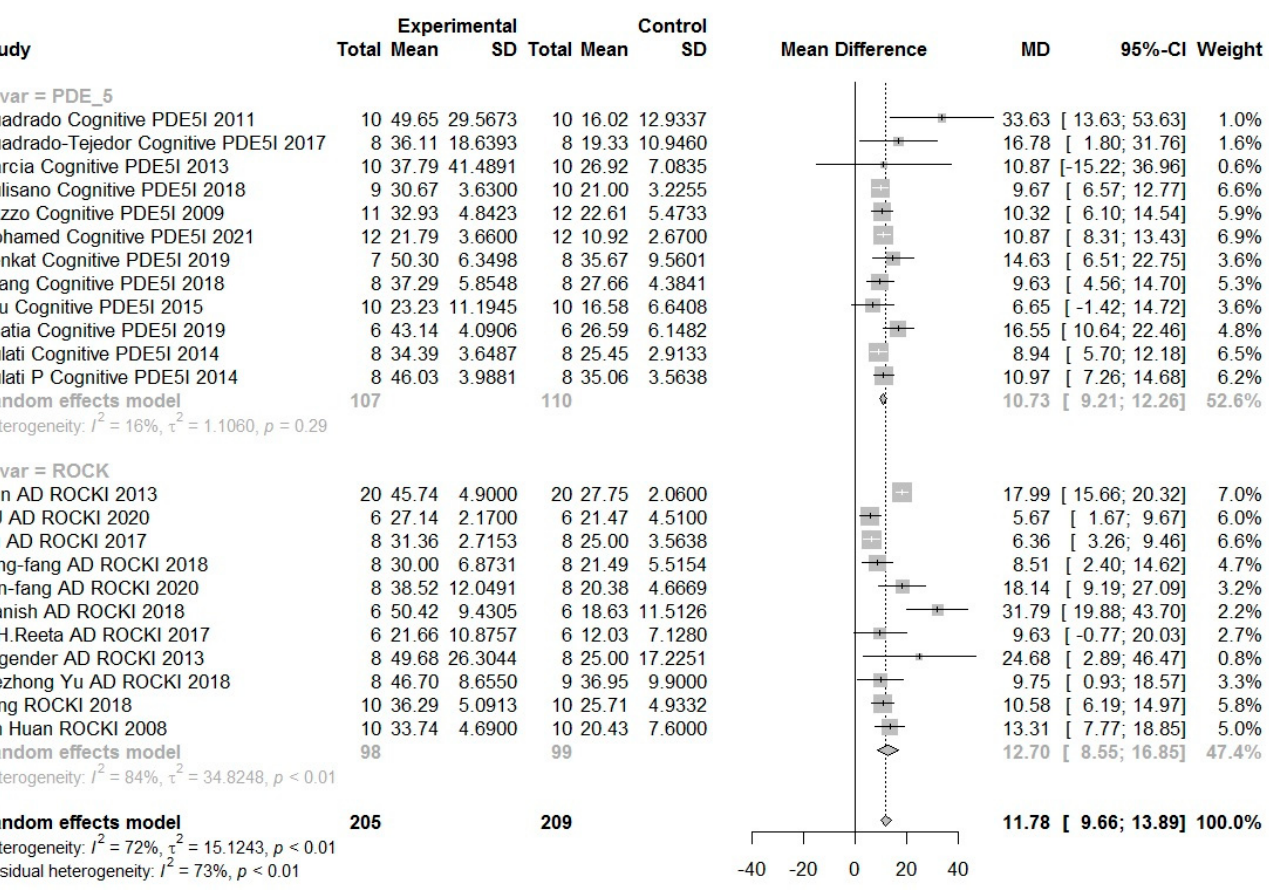
Figure 5. This forest plot shows an analysis of the difference between the experimental group and the control group of each subgroup by standardized mean difference (SMD). Because of the high heterogeneity, each group was analyzed by dividing it into subgroups. SD: standard deviation.